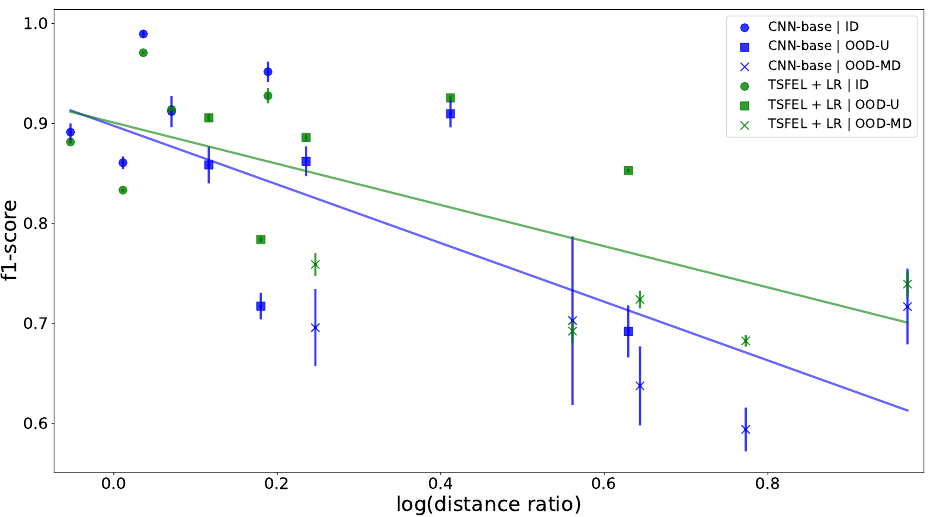
Figure 6. F1-score vs. log(distance ratio). Each marker represents a different task. Distance ratios are based on the CNN-base embeddings. Error bars represent one standard deviation away from the mean. The natural logarithm was applied to the distance ratios to make the regression curves linear.